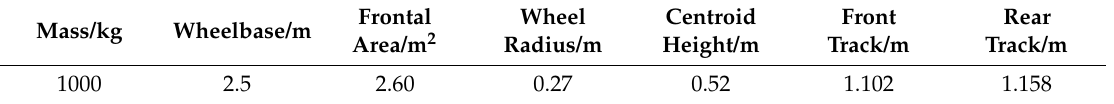
Table 2. Basic parameters of the simulation sample car.